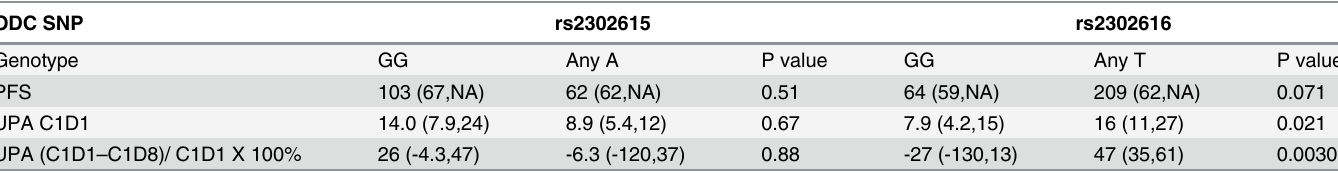
Table 6. Association of ODC genotypes with polyamine markers and treatment